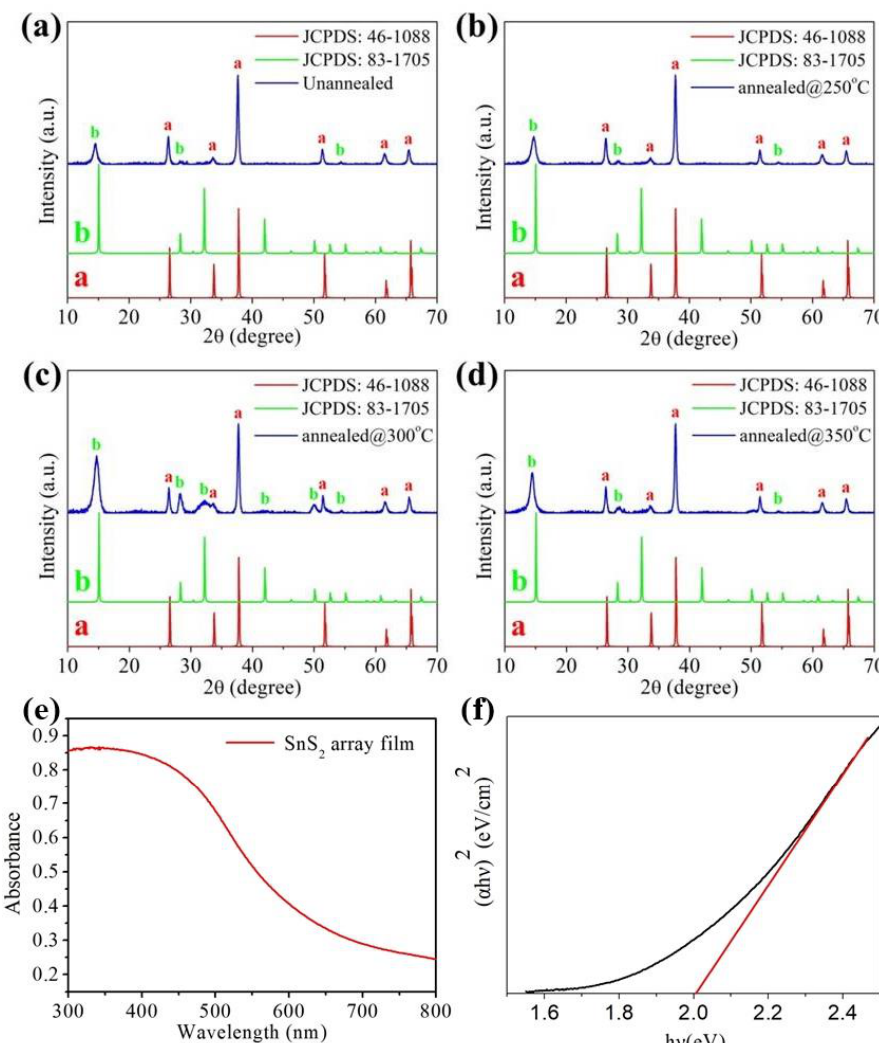
Figure 3. XRD pattern of pristine SnS 2 films ( a ) unannealed, and annealed at different temperatures ( b ) 250 °C, ( c ) 300 °C and ( d ) 350 °C. ( e , f ) are UV – vis absorption spectra and the corresponding plots of (α hν) 2 vs. hν of the pure SnS 2 array film annealing at 300 °C in N 2 atmosphere.